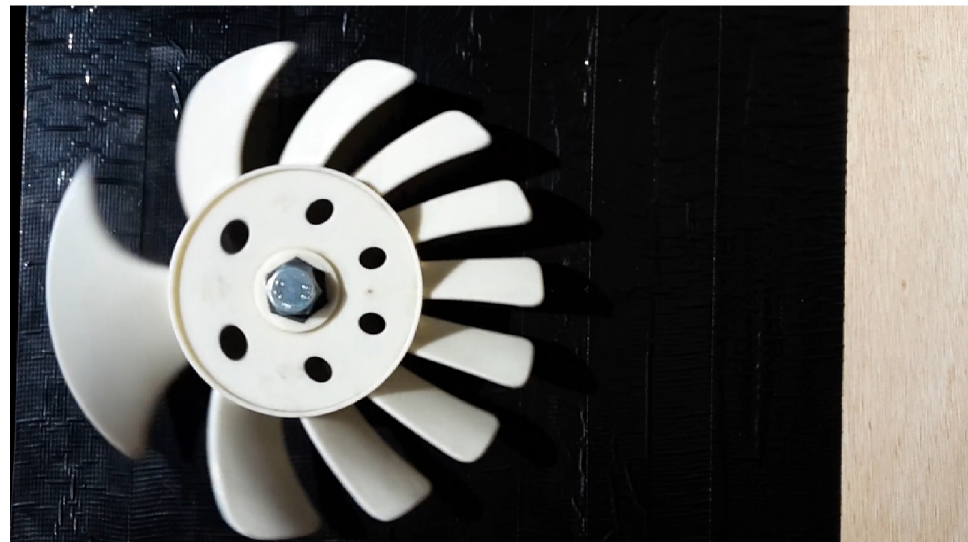
Figure 2. The thousandth frame of the video. The rolling shutter effect is highlighted as a deformation of the blades.